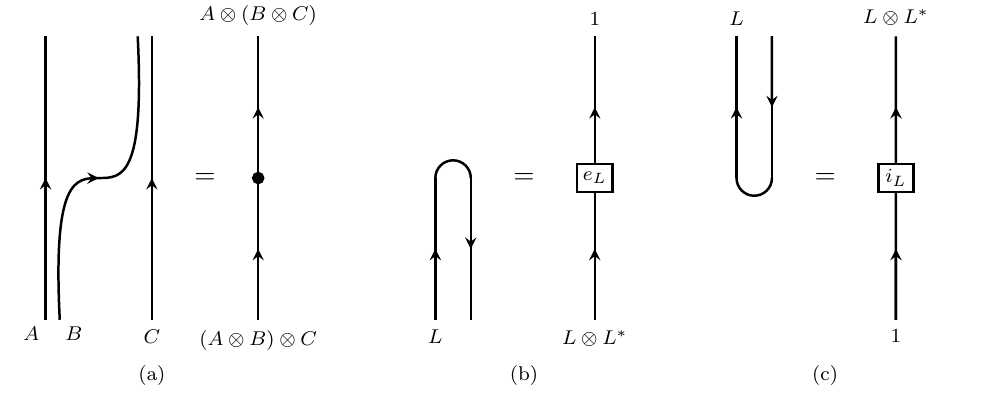
Figure 9 . Canonical maps: (a) Placing the lines as shown and fusing them gives rise to a canonical associator map. (b) Folding a line as shown and fusing it with itself gives rise to a canonical evaluation map. (c) Folding a line as shown and fusing it with itself gives rise to a canonical co-evaluation